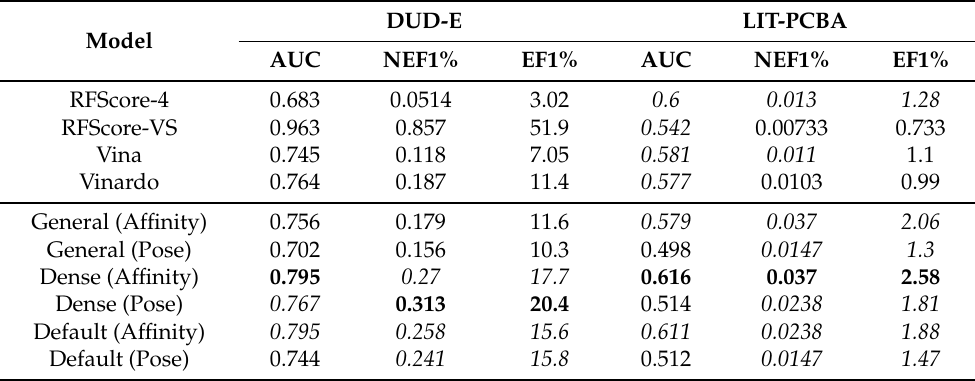
Table 2. Median AUCs, NEF1% and EF1% values on DUD-E and LIT-PCBA. Mean values are provided in Table S2. The best CNN model value for each column is shown in bold. Models whose distributions of per-benchmark metrics are not statistically dissimilar to the model in bold (as computed with a Mann-Whitney U rank test, p -value > 0.05) are shown in italic. RFScore-VS is the only model that was trained on